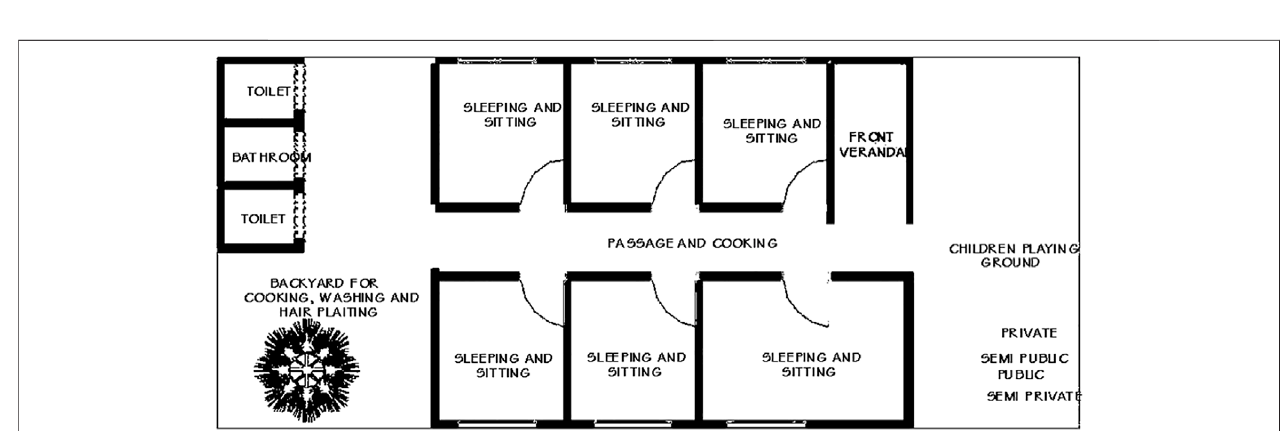
Frontiers in Built Environment |